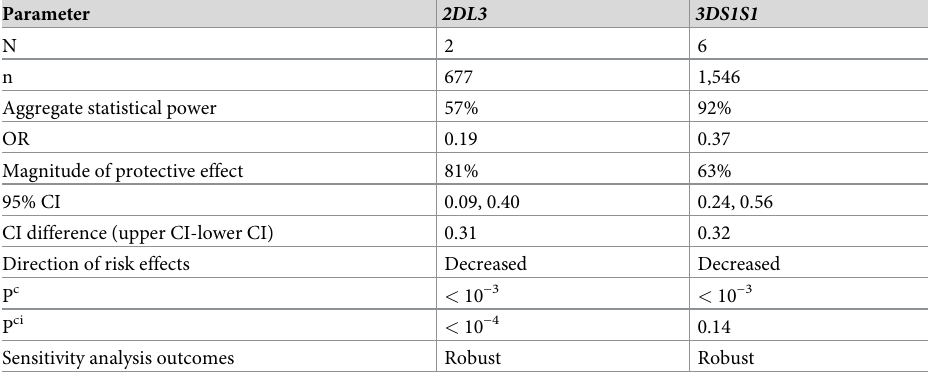
Table 6. Comparative summary effects between 2DL3 and 3DS1S1 on HIV acquisition in Caucasians in